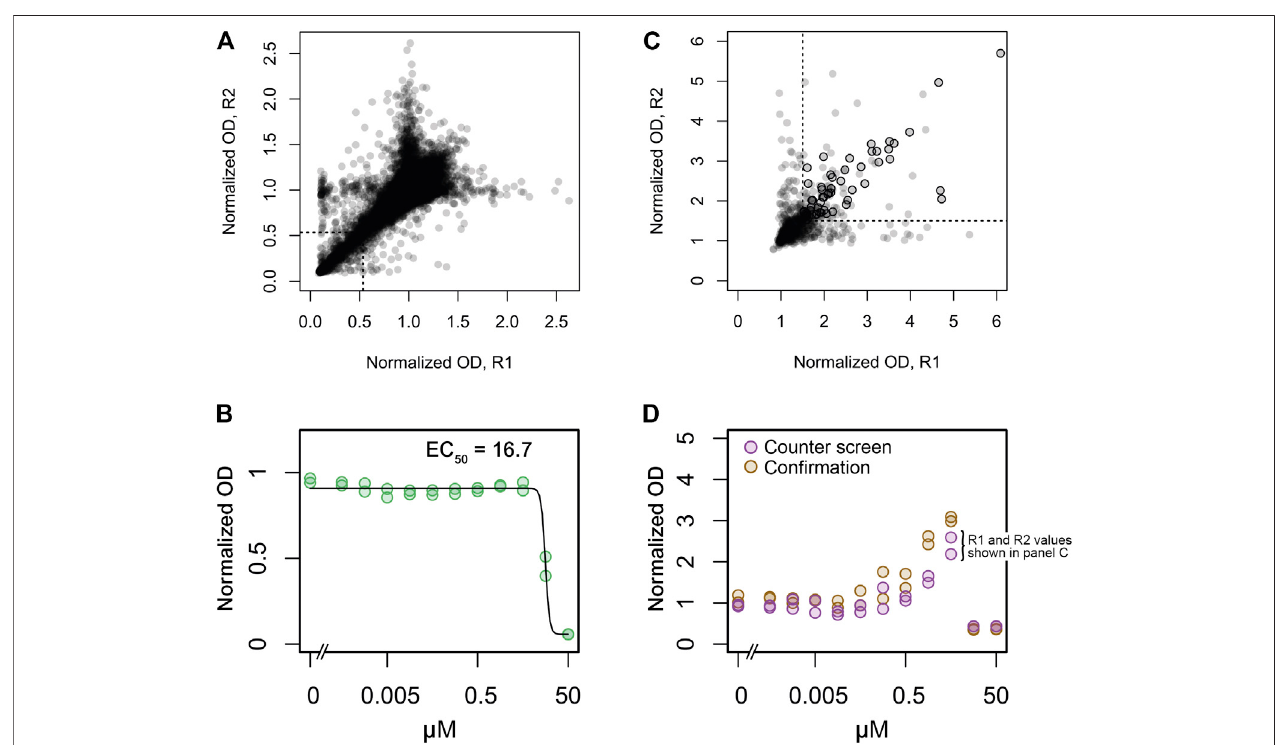
FIGURE 2 | Replicate plots and hit selection for screens of growth inhibition in wild type S. aureus and growth stimulation in the S. aureus clpX mutant. (A) A collectionof50,000syntheticsmallmoleculeswasscreenedat10 μ Mforgrowthinhibitionofthewildtypestraininduplicate.NormalizedODvaluesforreplicates1and2 isdepictedonthex-and y -axes,respectively.Astatisticalcutoffofthreestandarddeviationsbelowthemeanwasestablishedforbothreplicates,indicatedbythedotted lines in the lower left corner. Data points to the left and below these lines represent the 993 active compounds. (B) 828 of the 993 active compounds were con fi rmed at concentrations ranging from 0.5 nM to 50 μ M in duplicate. Dose-dependent inhibition by one con fi rmed active compound is shown as an example. Normalized OD values for the two replicates are indicated by green circles. A calculated dose-response curve (black line) and the calculated EC50 value is also shown. (C) The828con fi rmedactivecompoundswereassessedforgrowthstimulationofthe clpX mutantat30 ° Catconcentrationsrangingfrom0.5 nMto50 μ Minduplicate. For each compound the highest obtained normalized OD values of replicates 1 and 2 is depicted on the x and y -axes, respectively, (these values are also indicated in panelDforoneexamplecompound).AnormalizedODvalueof1.5wasusedascutoff,indicatedbydottedlines.Datapointstotherightandabovetheselinesrepresent clpX stimulatorycompounds,andblackcirclesindicatethe58compoundsthatweresubsequentlycon fi rmedbymanualinspectionofdose-responseplotsandre-tests. (D) Dose-dependent growth stimulation by one clpX stimulatory compound (same compound as in panel B) is shown as an